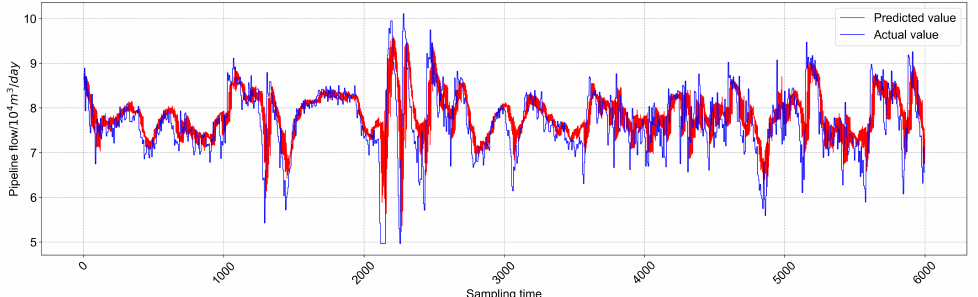
Figure 9. Prediction results of the NG pipeline flow from the proposed